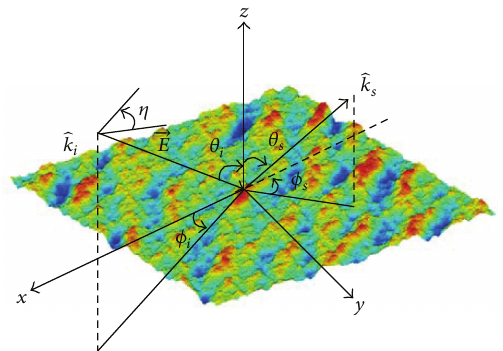
Figure 2: Definition of scattering geometry with relevant parameters in the coordinate